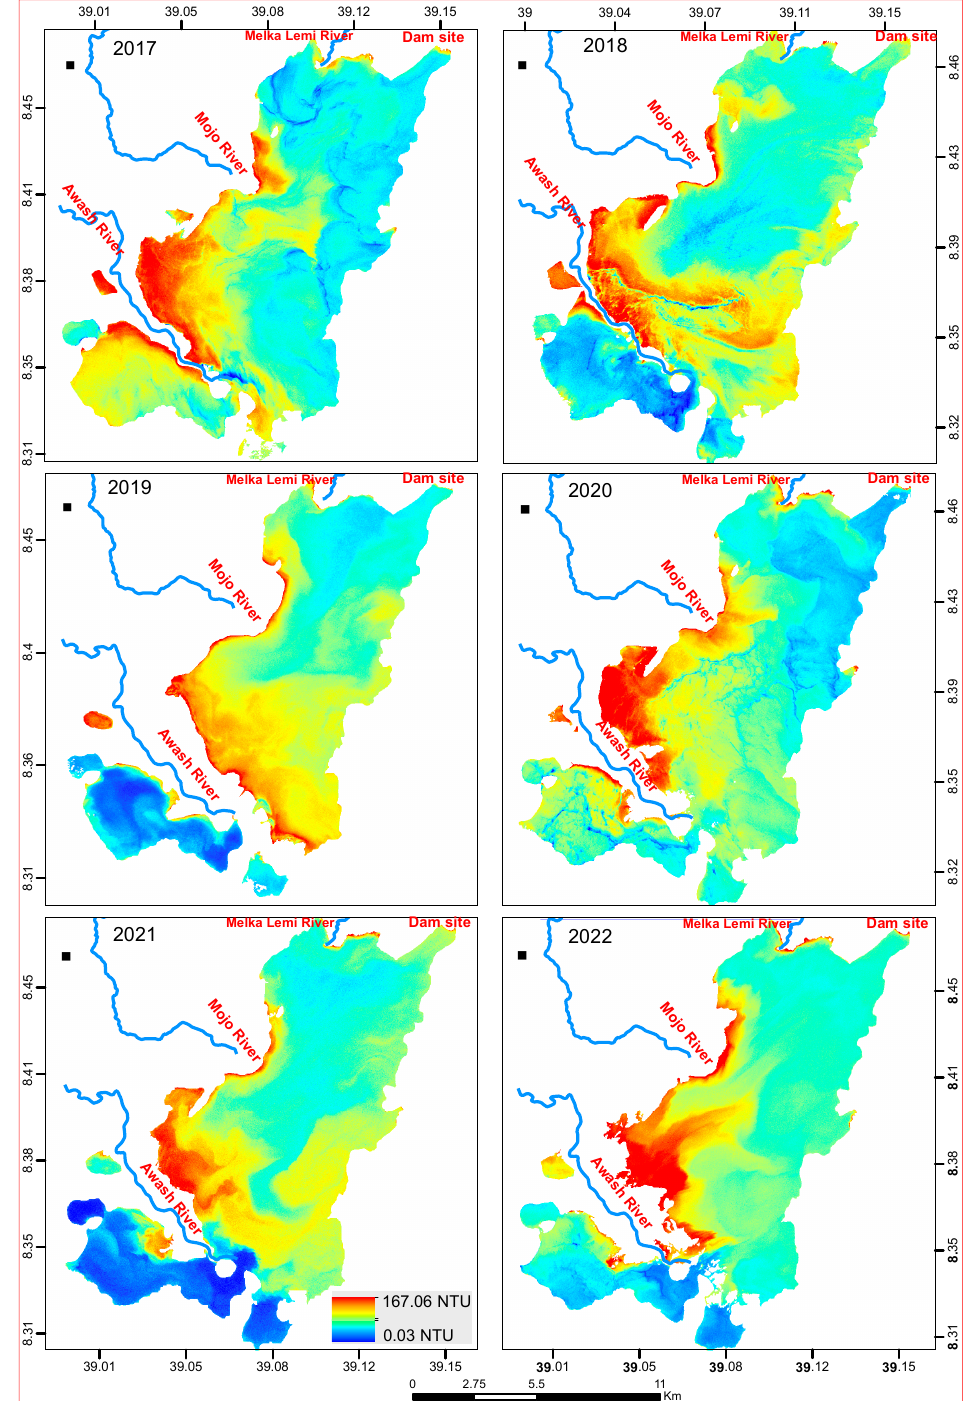
Figure 10. Annual distribution map of TU (NTU) from Sentinel-2 imagery using linear regression models.